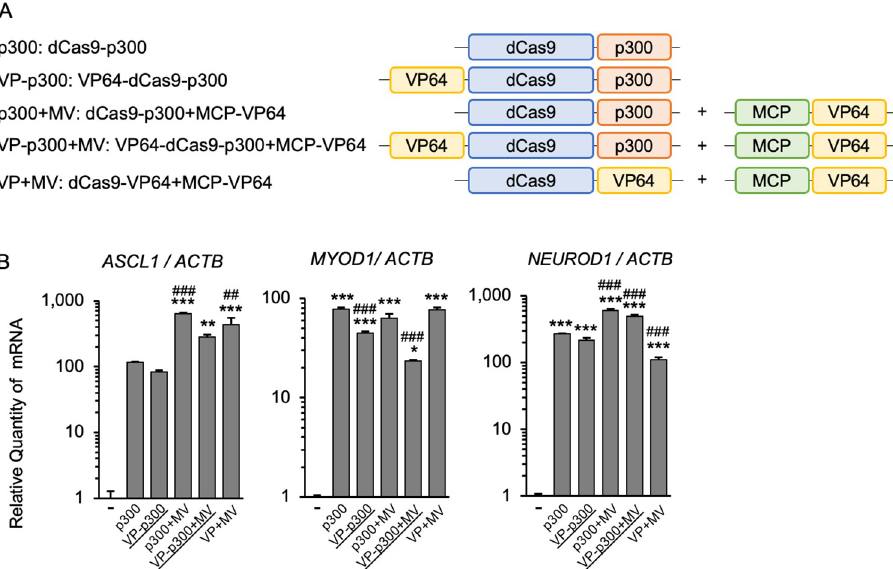
Fig 3. Analysis of combined VP64 and dCas9-p300 CRISPRa systems. (A) Schematic diagrams of the CRISPRa systems evaluated. VP-p300 and VP-p300+MV are novel. (B) RNA expression of three endogenous genes was tested in human HEK293T cells transfected with the indicated CRISPRa systems. The addition of VP64 to p300 by MS2-MCP scaffolding (to make p300+MV) enhanced transcriptional activation vs. p300 alone. Direct fusion of VP64 to the N- terminus of dCas9 (to make VP-p300) reduced the activity of transcriptional induction vs. p300 alone. Addition of VP64 to dCas9-p300 by MS2-MCP-VP64 (to make p300+MV) was more advantageous than direct fusion of VP64 (to make VP-p300+MV and VP-p300+MV). Error bars indicate the mean ± SE (n = 3). Statistical analysis was performed using one-way ANOVA with Tukey’s multiple comparisons test. � , P < 0.05; �� , P < 0.01; ��� , P < 0.005 vs. non- induced control, ## , P < 0.01; ### , P < 0.005 vs.